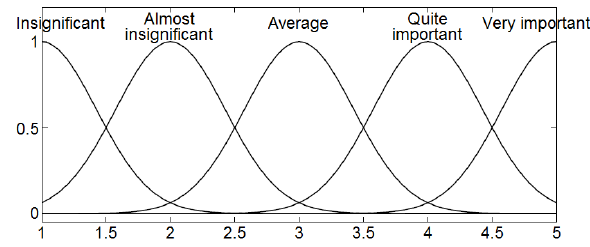
Figure 8: Membership function for the input variable x 2 – EFF(Uph) , Gaussian functions